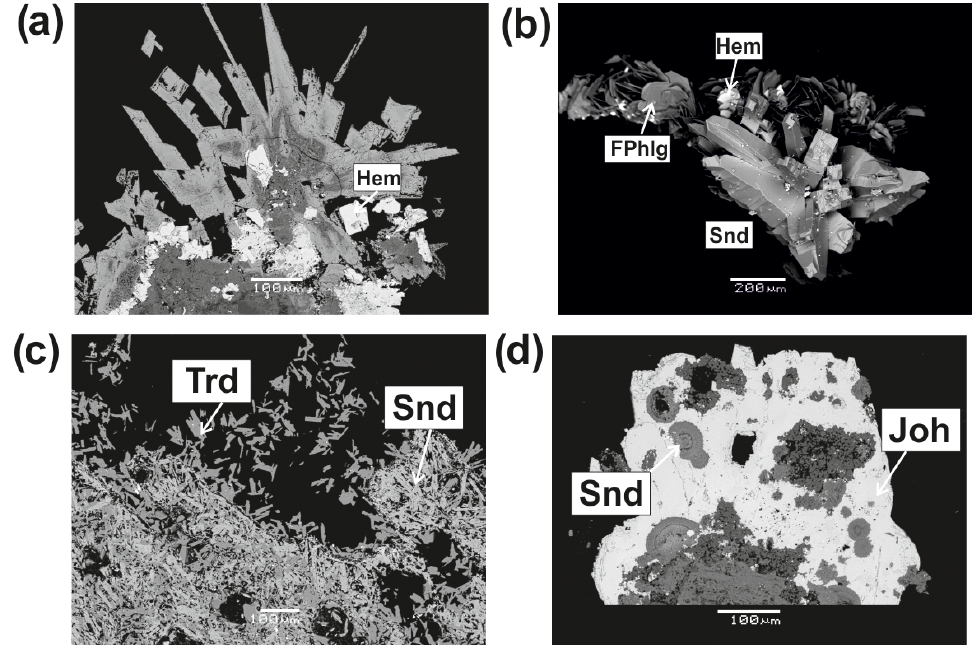
Figure 2. As-bearing sanidine from the Arsenatnaya fumarole: spear-like zoned crystals with hematite (Hem), polished section (a) ; well- shaped twinned crystals with fluorophlogopite (FPhlg) and hematite (Hem) (b) ; open-work aggregates of As-bearing sanidine with tridymite (Trd) (c) ; spherulites of As-bearing sanidine embedded in johillerite (Joh) (d) . Backscattered electron (BSE)